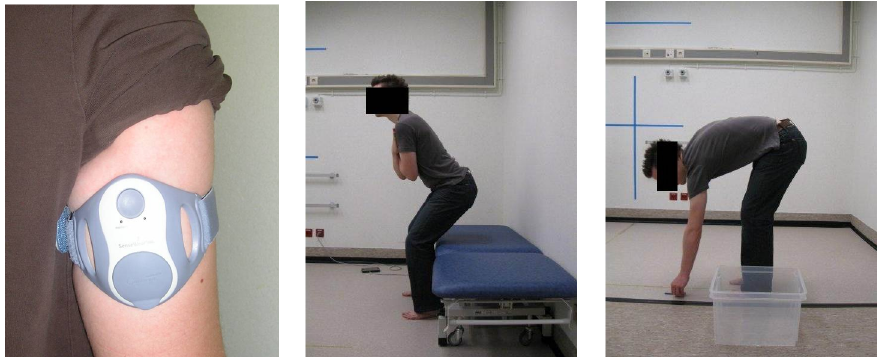
Figure 1. Example of a mounted sensor and a patient resp. sitting down and picking up a